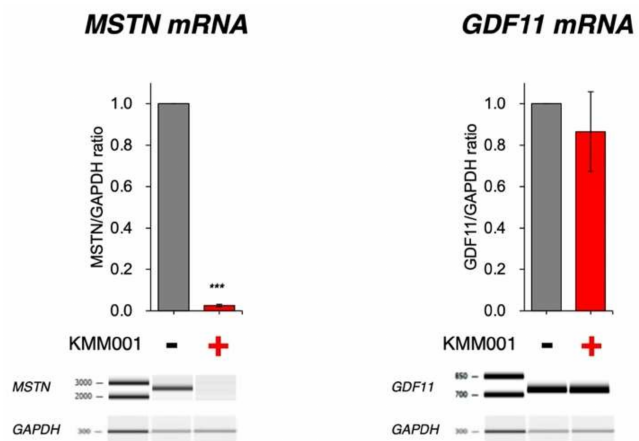
Figure 6. KMM001 did not decrease GDF11 mRNA levels. To determine the effect of KMM001 on the expression of GDF11 , CRL-2061 cells were treated with 100 nM KMM001, and the MSTN and GDF11 mRNA sequences were amplified by RT − PCR. Electrophoretograms of the amplified products and their MSTN/GAPGH and GDF11/GAPGH ratios are shown in the graph. The MSTN/GAPDH ratio decreased to 0.03, indicating strong inhibition ( p < 0.001). On the other hand, the GDF11/GAPDH ratio decreased to a level of 0.87 upon addition of KMM001. *** = p < 0.001 vs. no